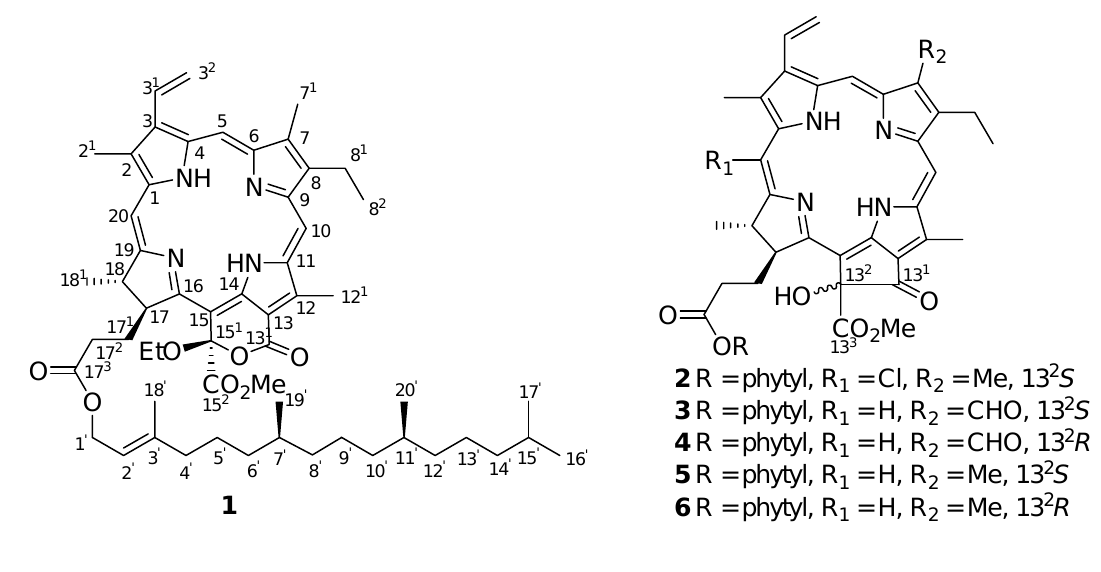
Figure 1 . Structures of compounds 1 - 6